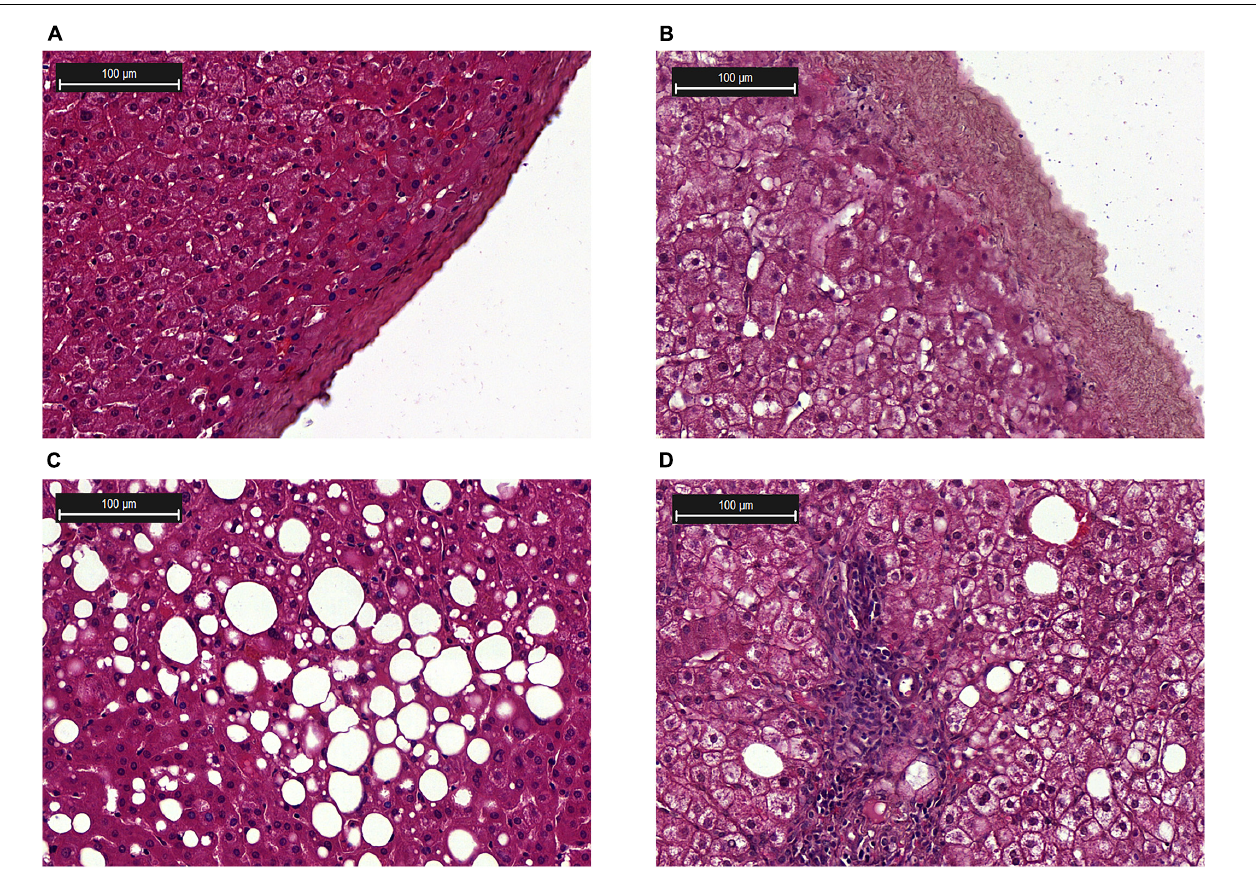
FIGURE 2 | Histological examination of the liver biopsies. (A) Liver capsule from a healthy donor; (B) Liver capsule with inflammation; (C) Steatosis; (D) NASH, lymphocytic infiltration in the tissue. Hematoxylin and eosin (H&E)